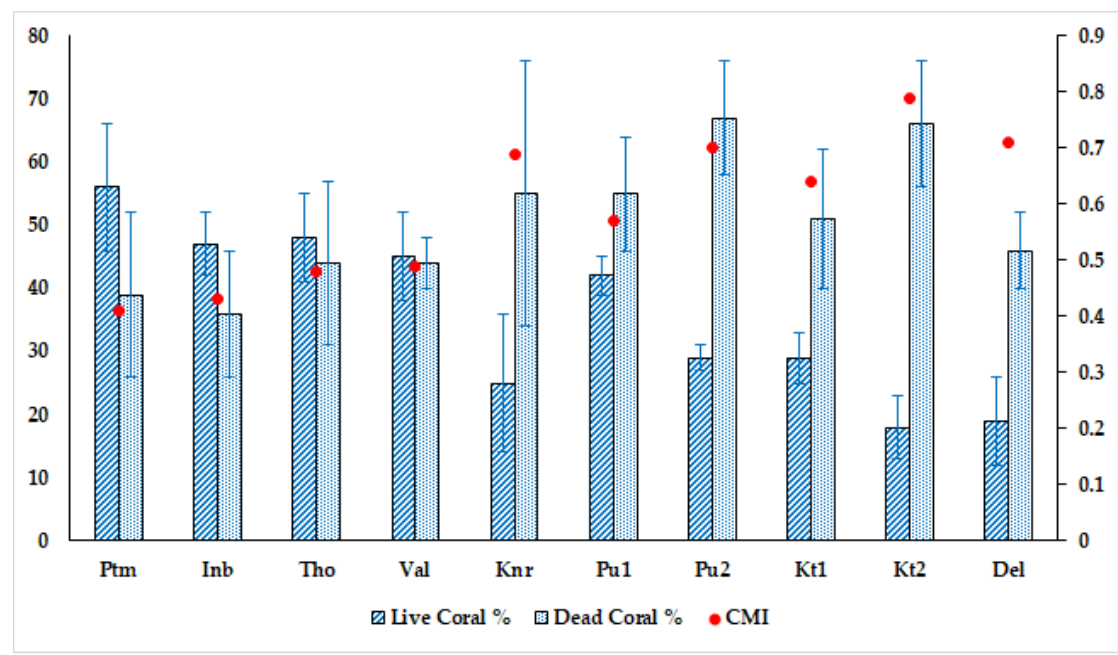
Figure 3. Percentages of live coral cover and dead coral cover, together with the values of the Coral Mortality Index (CMI) on coral reefs at each of the study sites.